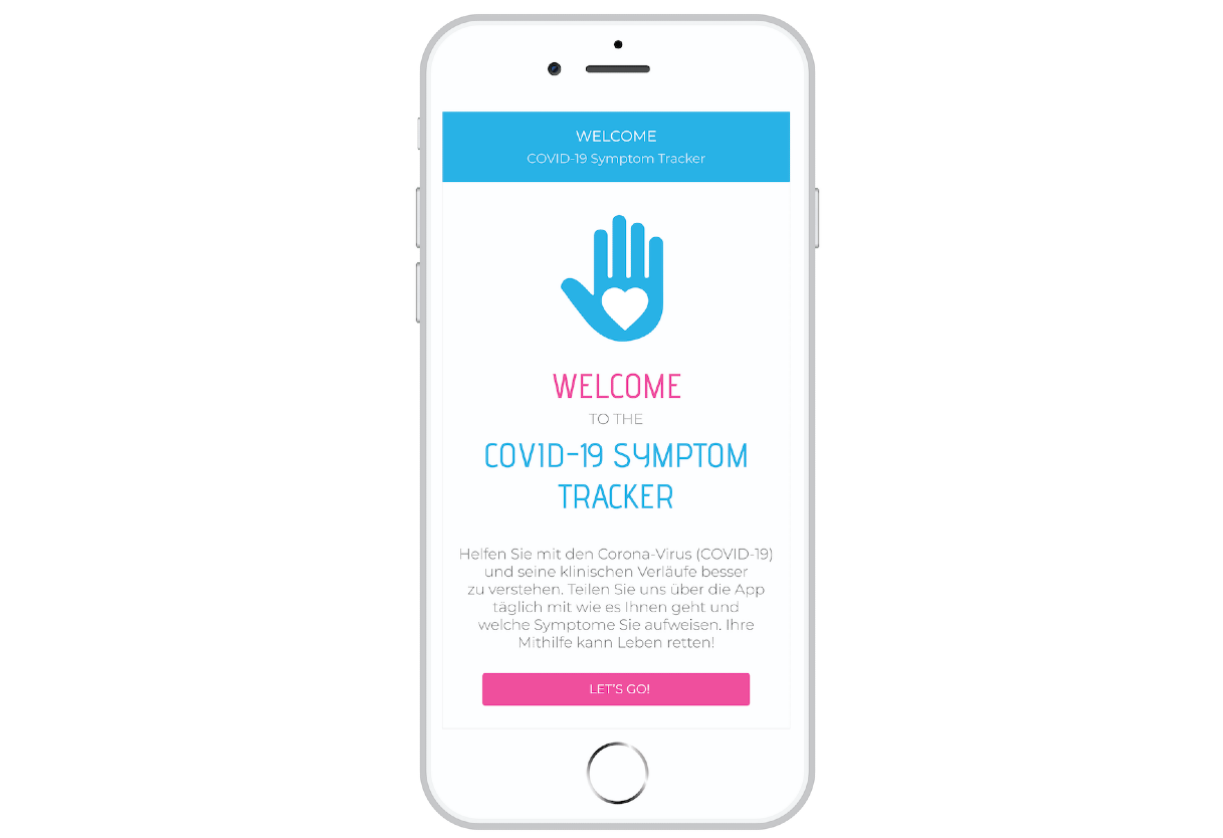
Figure 1. The COVID-19 Symptom